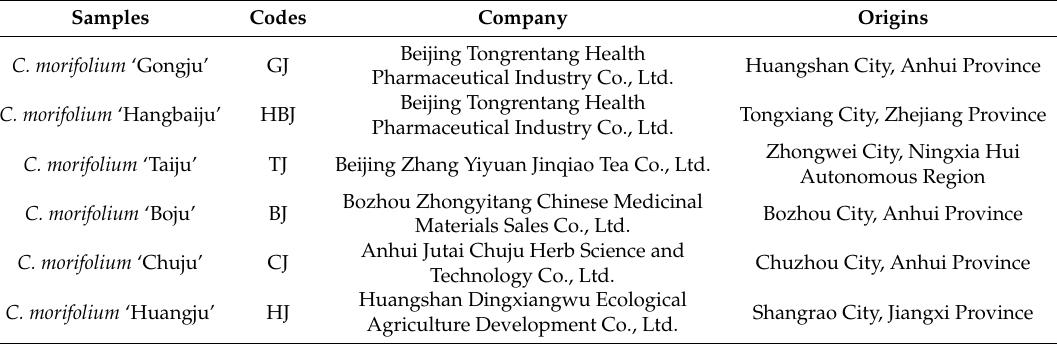
Table 1. Samples and origins of the studied Chrysanthemum morifolium flower tea from